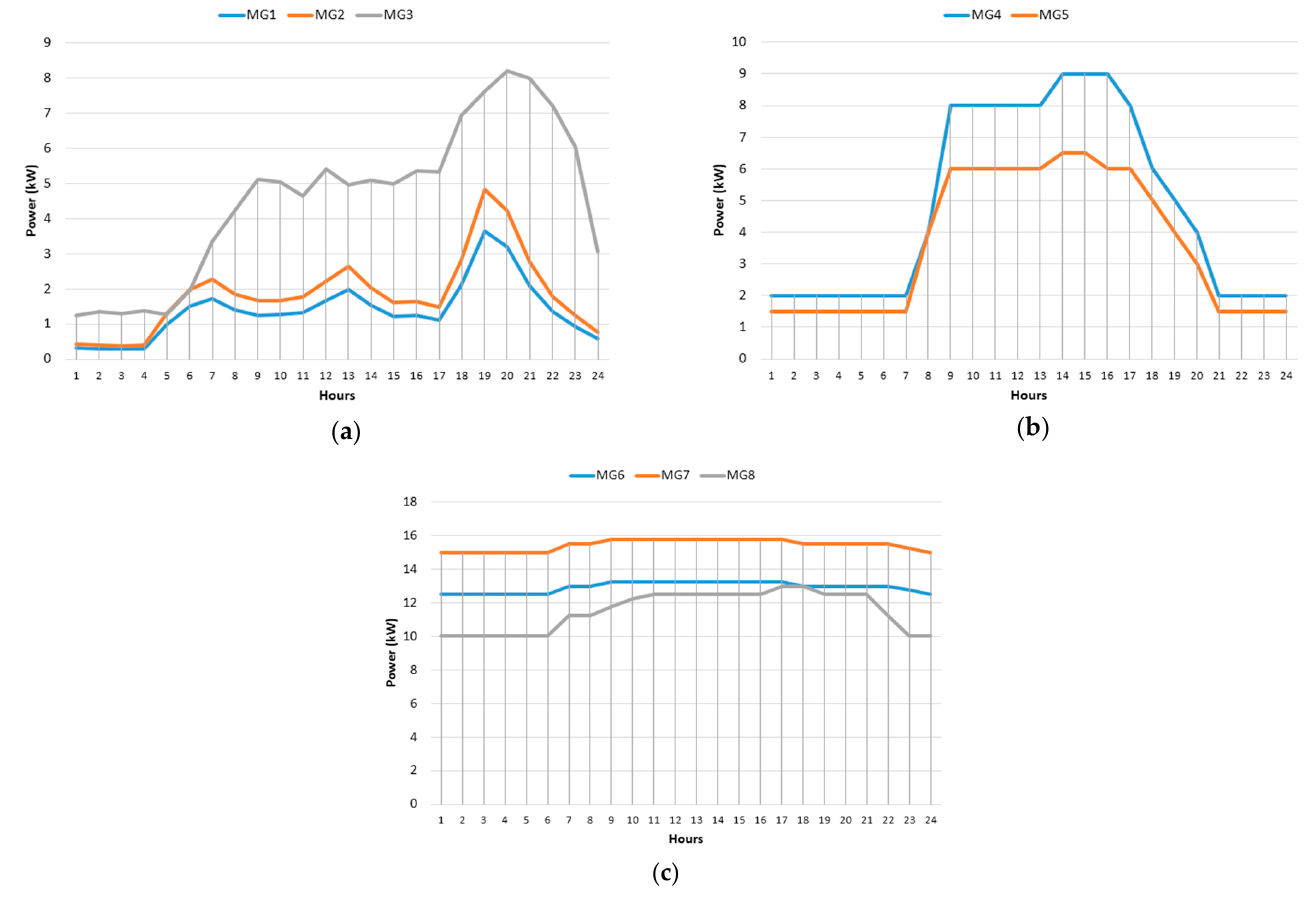
Figure 4. Residential, commercial, and industrial load pattern. ( a ) Residential load profile, ( b ) Commercial load profile, ( c ) Industrial load profile.